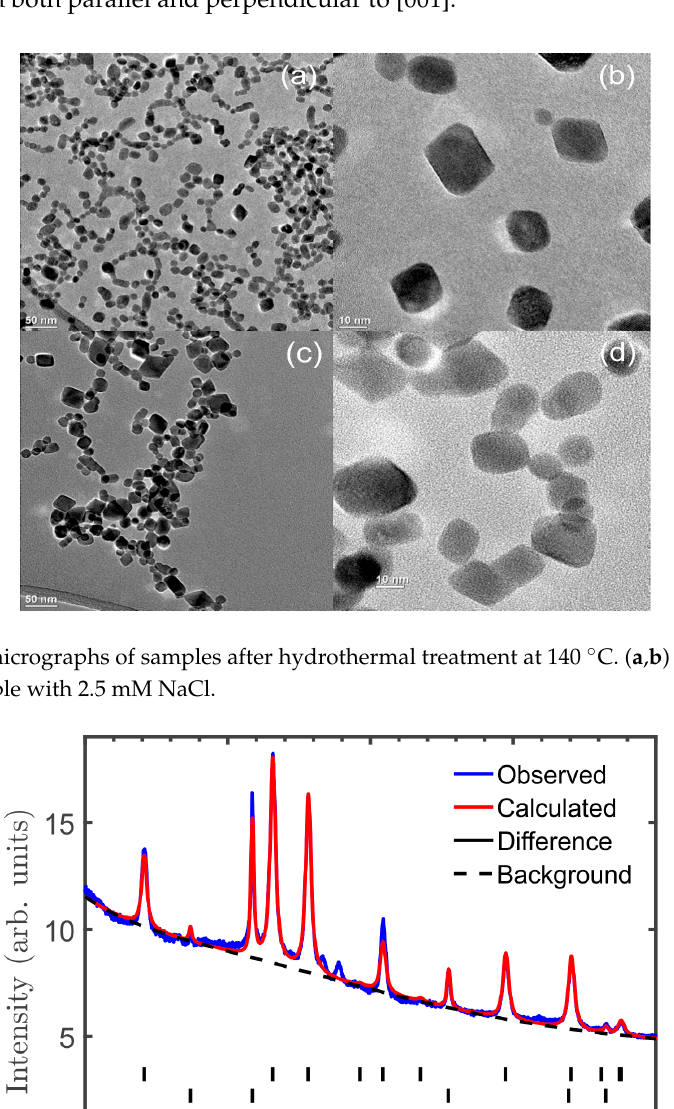
Figure 10. XRD patterns of the 2.5 mM NaCl sample after hydrothermal treatment at 140 °C. The upper tick marks correspond to the hematite structure, the lower to the NaCl structure.